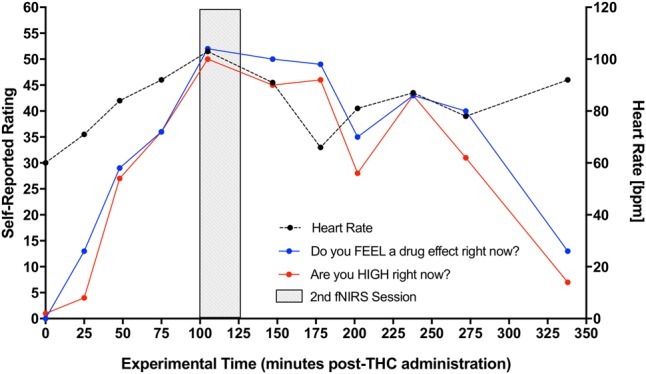
Increase in participants’ self-reported rating of intoxication and measured heart rate post-dronabinol administration. Every 25 min participants answered two questions: (1) “Do you FEEL a drug effect right now?” and (2) “Are you HIGH right now?” on a 0–100 mm visual analog scale, 0 mm being “Not at all” and 100 mm being “Extremely.” Subjects’ heart rate was also collected at each 25-min interval. The graph depicts averaged participants’ ratings and heart rate measurements. Second fNIRS session was completed at approximately 100–125 min post-dronabinol administration (shaded block).